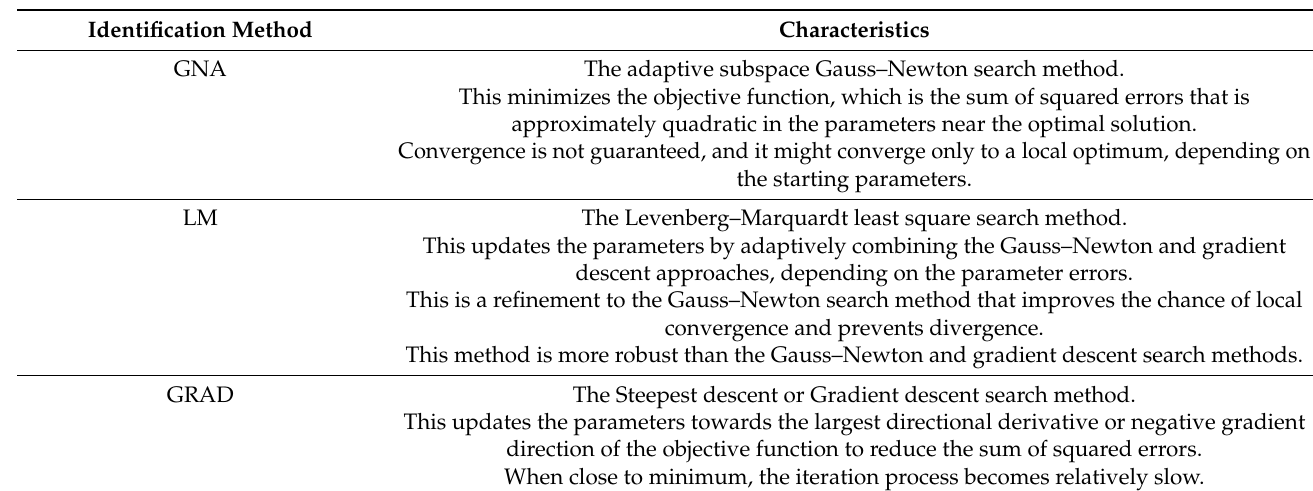
Table 2. General characteristics of each identification